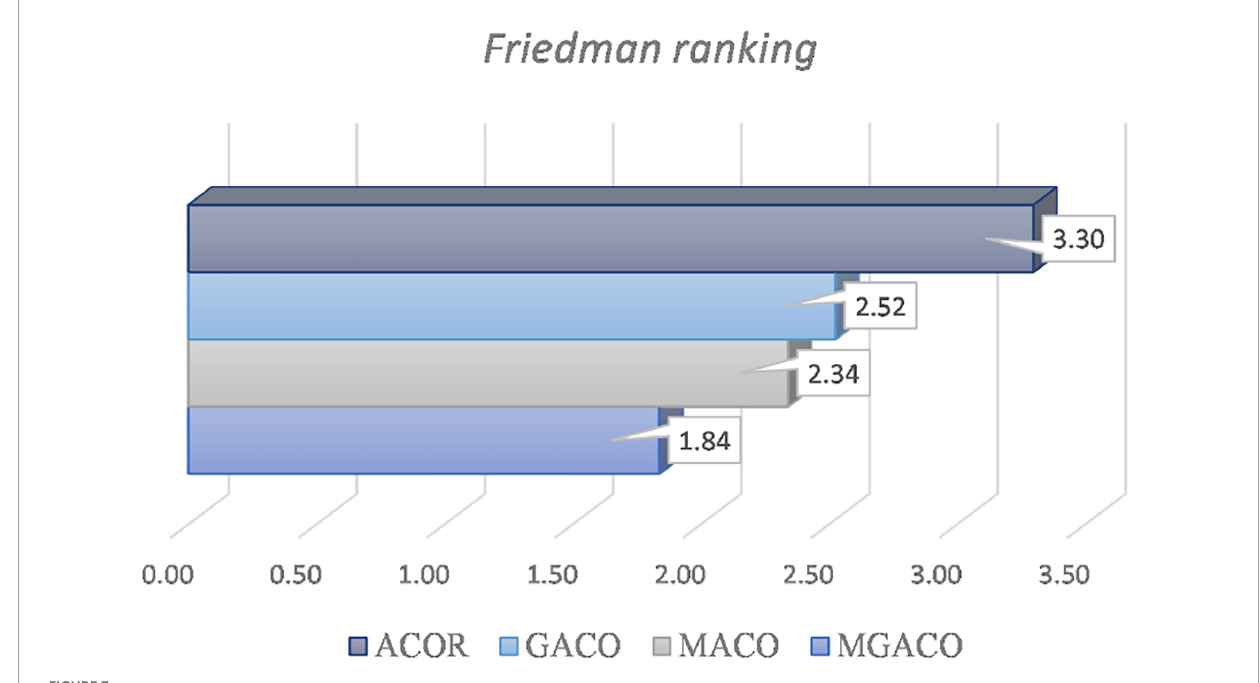
FIGURE7 Some convergence curves on benchmark functions.